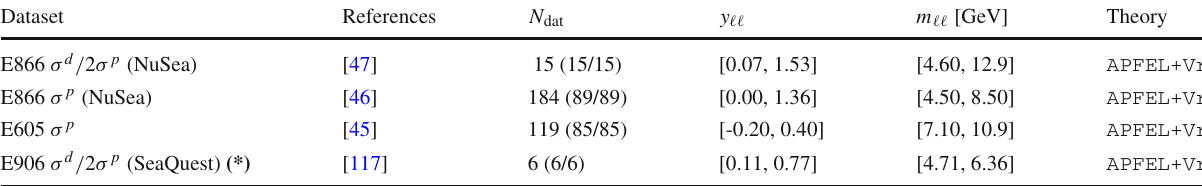
Table 3 Same as Table 1 for fixed-target DY data